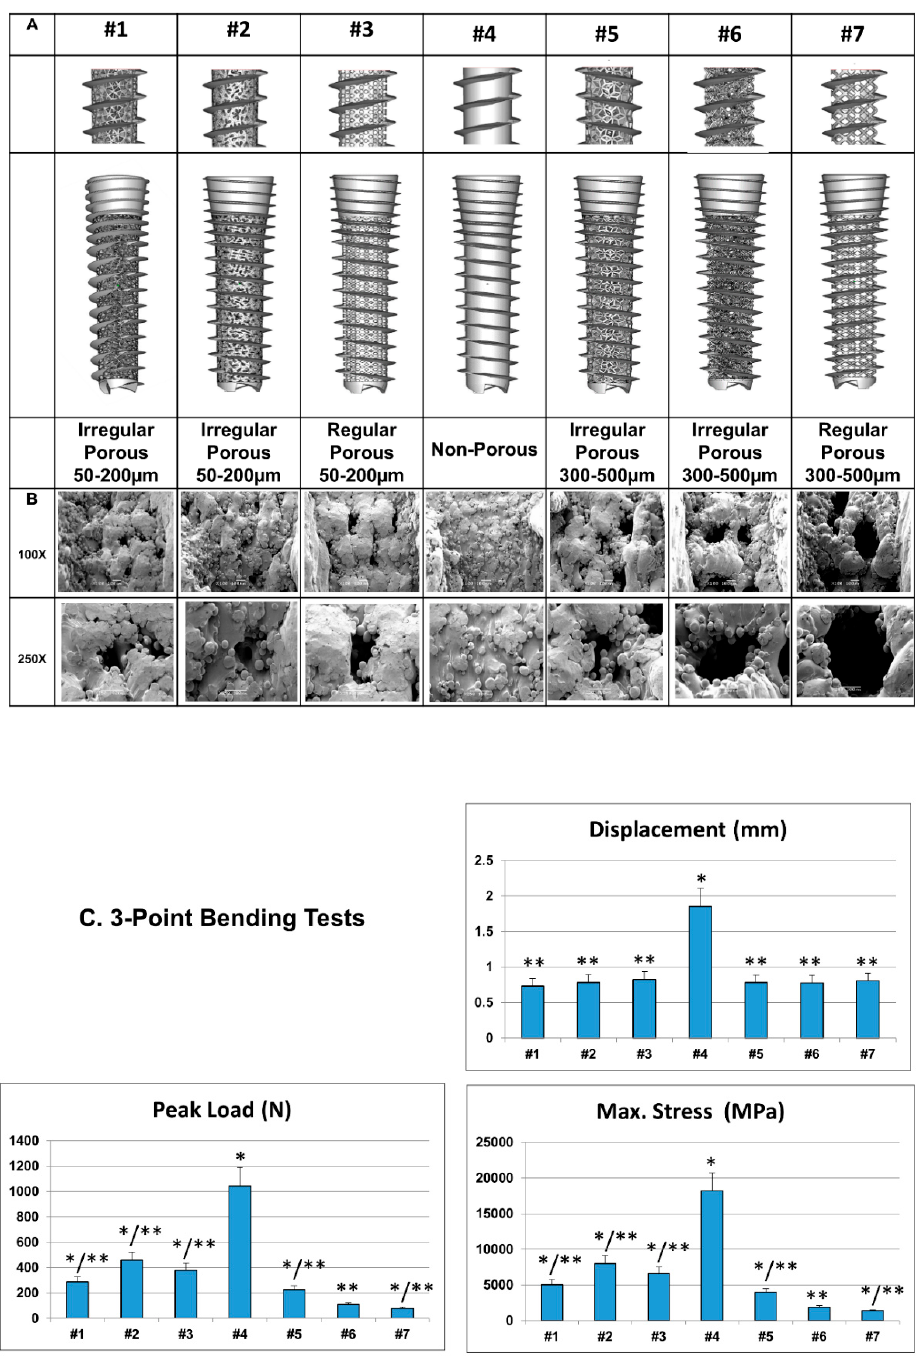
Figure 1. Gross morphology of the biomimetic direct metal laser sintering (DMLS) Ti 6 Al 4 V dental implants. ( A ) External characterization: the computer-assisted-design (CAD) of the external configurations of the seven different dental implants. ( B ) Scanning electron microscopy (SEM) images. SEM images showed no inter-layer difference when probed on the external portion of the implants. Although the surfaces of the implants were very rough, the struts were well formed and continuous. Bar = 100 µ m. ( C ) Biomechanical parameters (3-point bending test) of the biomimetic Ti 6 Al 4 V dental implants. The non-porous design had superior biomechanical profiles compared to the porous designs. (n = 7 for each design. * indicates significant differences when compared to #6 dental implant; ** indicates significant differences when compared to #4 dental implant).